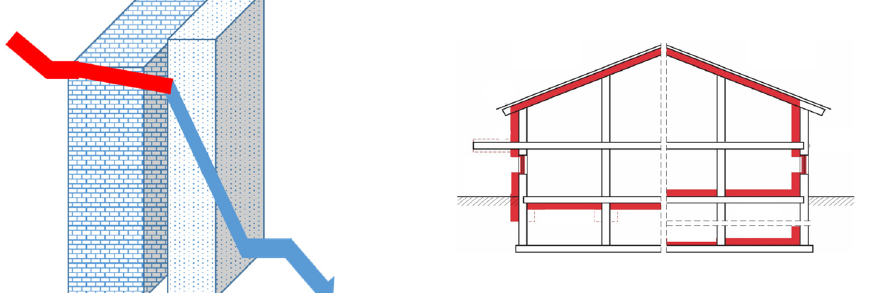
Figure 1. Heat flow through a brick wall combined with an insulation layer ( left ) and possible external and internal positions of insulation material in house construction alongside walls, roof, and flooring ( right ).